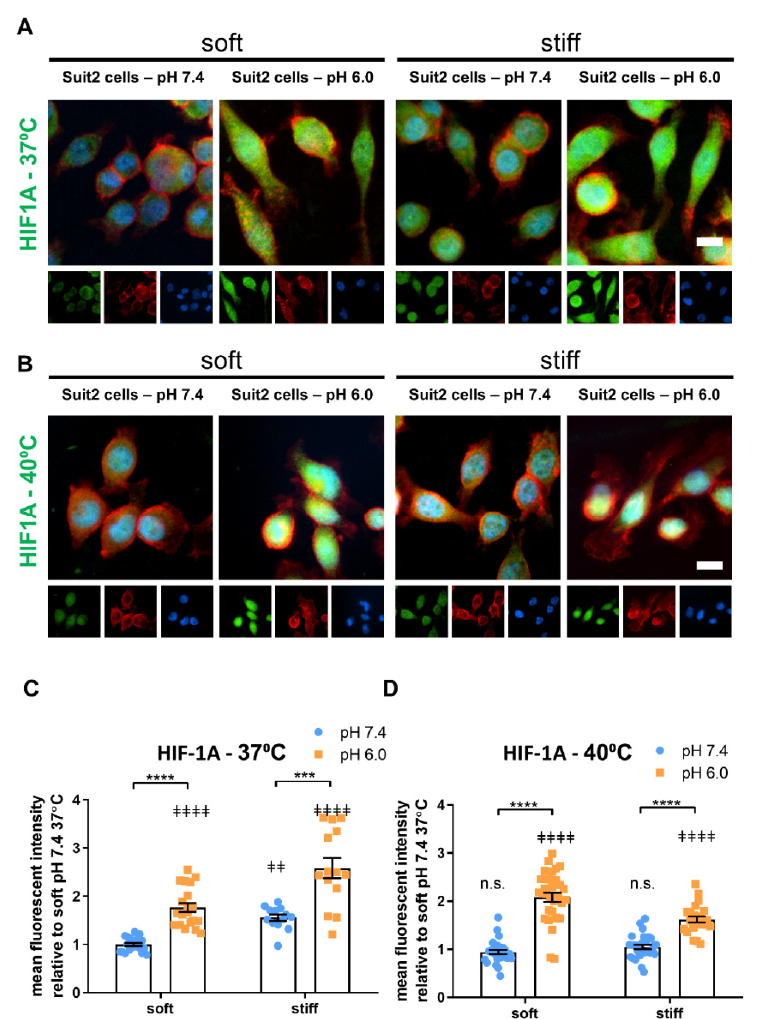
Figure 6. Acidic pH (6.0) of culture media and tumor-mimicking stiffness of the substrate increase the expression of Hypoxia Inducible Factor 1 Alpha in Suit-2 007 cells. ( A , B ) Widefield, epifluorescent images of HIF1A for cells cultured on soft (Gamma 2) and stiff (Alpha 2) Manchester BIOGEL PeptiGels in physiologically healthy (7.4) and tumor-mimicking (6.0) pH at 37 °C ( A ) and 40 °C ( B ). Protein of interest (green), actin (red) and nucleus (blue). Scale bar represents 20 µm. ( C , D ) Protein expression measured as the MFI-mean fluorescence intensity (expressed in arbitrary units) of HIF1A-stained cells presented in ( A , B ), respectively. Histogram bars represent the mean ± SEM, and dots represent the average yap nuclear/cytoplasm ratio within a sample (20 cells measured per sample) across three experimental replicates. * Markers denote a significant difference between bracket-marked groups by t -test, *** 0.0001 < p < 0.001 and **** p < 0.0001. ‡ markers denote a significant difference from soft pH 7.4 condition at 37 ◦ C by ANOVA with Dunnett’s post hoc test; n.s not significant, ‡‡ 0.001 < p < 0.01, and ‡‡‡‡ p <